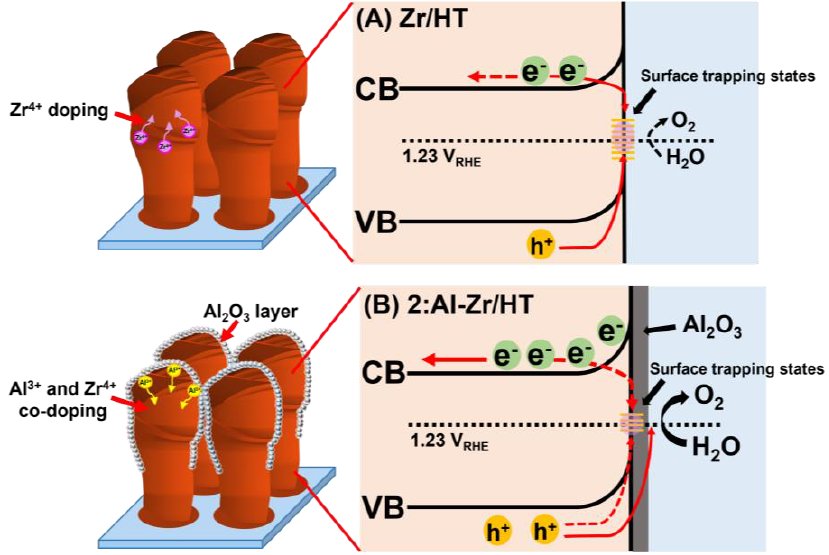
Figure 6. Photocurrent curve and hydrogen–oxygen evolution test under standard 1 Sun illumination in 1 M NaOH at 1.23 V vs. RHE of the CoPi/2:Al-Zr/HT photoanode (Inset: the three-electrode photoelectrochemical reactor).